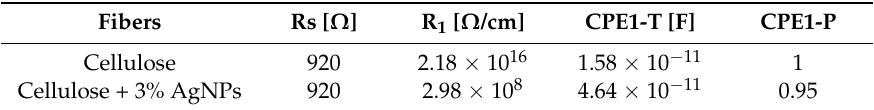
Figure 14. Electrical equivalent circuit. R s, resistance of electrical leads, R 1 , linear resistance of the sample, CPE, constant phase element. Table 4. The components value of electrical equivalent circuit of nanocomposite fibers. CPE-P, proximity to capacitance or resistance, CPE-T, capacitance.